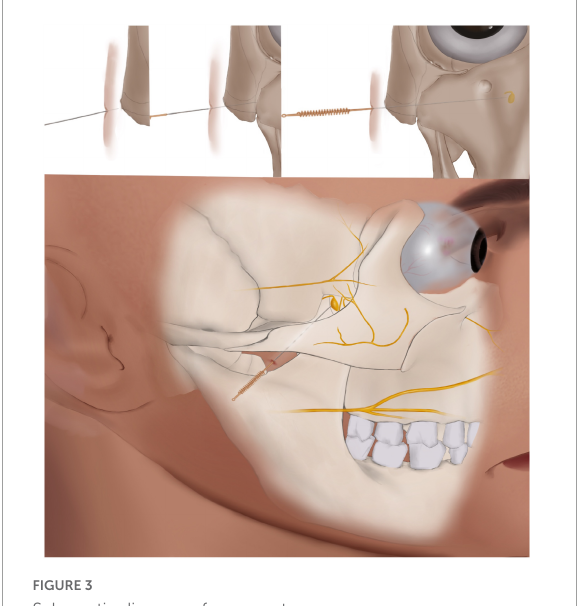
FIGURE3 Schematic diagram of